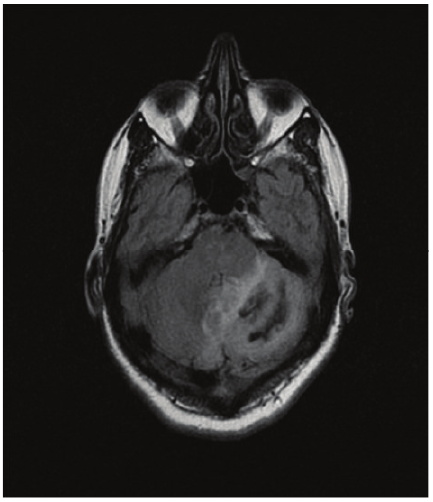
Figure 3: Cranial FLAIR enhancement MRI image showing left cerebellar